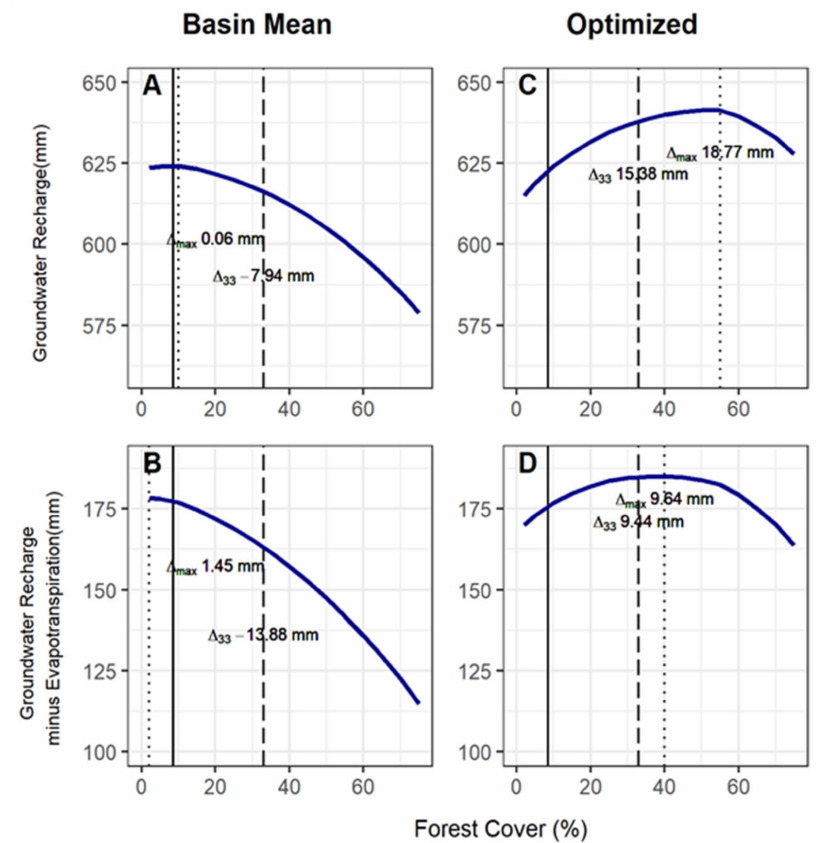
Figure 5. Central Indian Highland’s groundwater recharge over the range of forest cover from 2% to 75% of the landscape. Graph ( A ) represents the groundwater recharge for the basin mean pathway for increasing forest cover while Graph ( C ) represents groundwater recharge optimized pathway to increasing forest cover. Graphs ( B , D ) subtract the increase in evapotranspiration from groundwater recharge to represent water losses from the landscape because of increasing forest cover for the basin mean pathways ( B ) and groundwater recharge optimized pathway ( D ). ∆ 33 indicates the change from current forest cover (solid vertical line) to forest cover at 33% (dashed vertical line) while ∆ max indicates the change from current forest cover to the maximum (dotted vertical